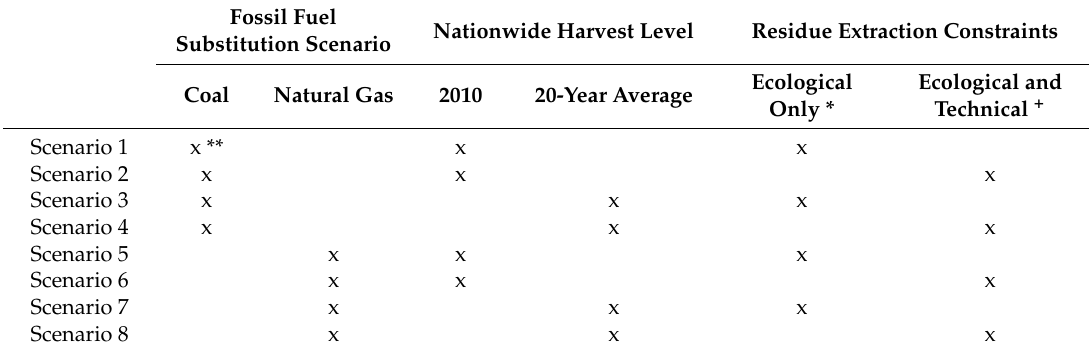
Table 1. Summary of coal and natural gas substitution